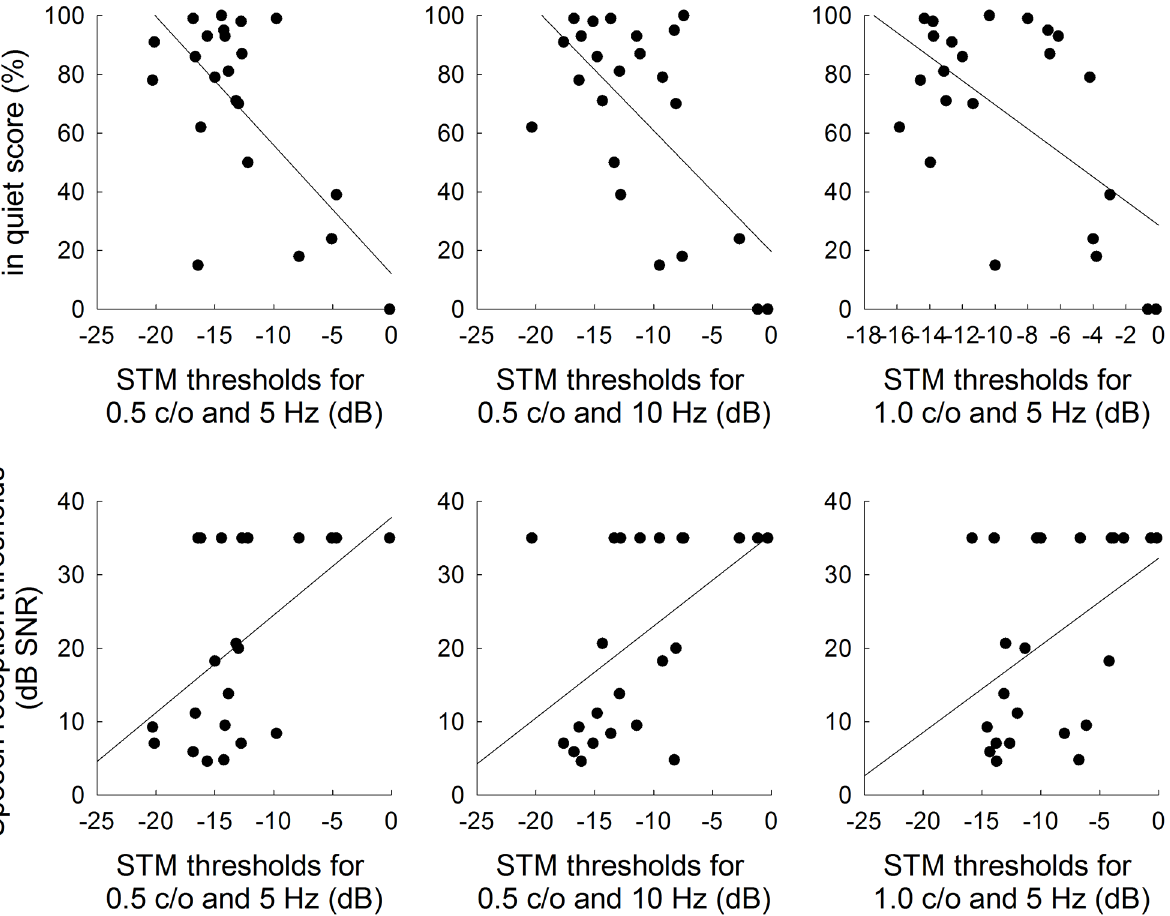
Fig 8. Relationship between STM detection and K-CID sentence recognition in quiet (upper panel) and HINT sentence recognition in noise (lower panel) for CI subjects. Linear regressions are represented by the solid lines.